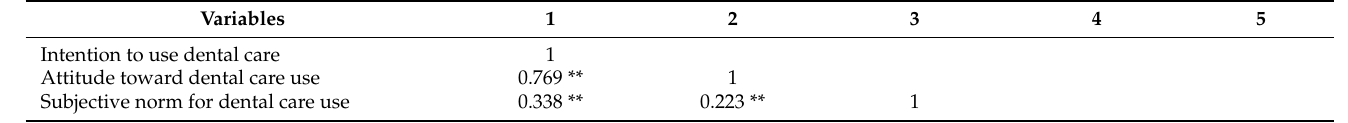
Table 3. Correlation between dental care use attitude, subjective norm, perceived behavioral control, intention to use and